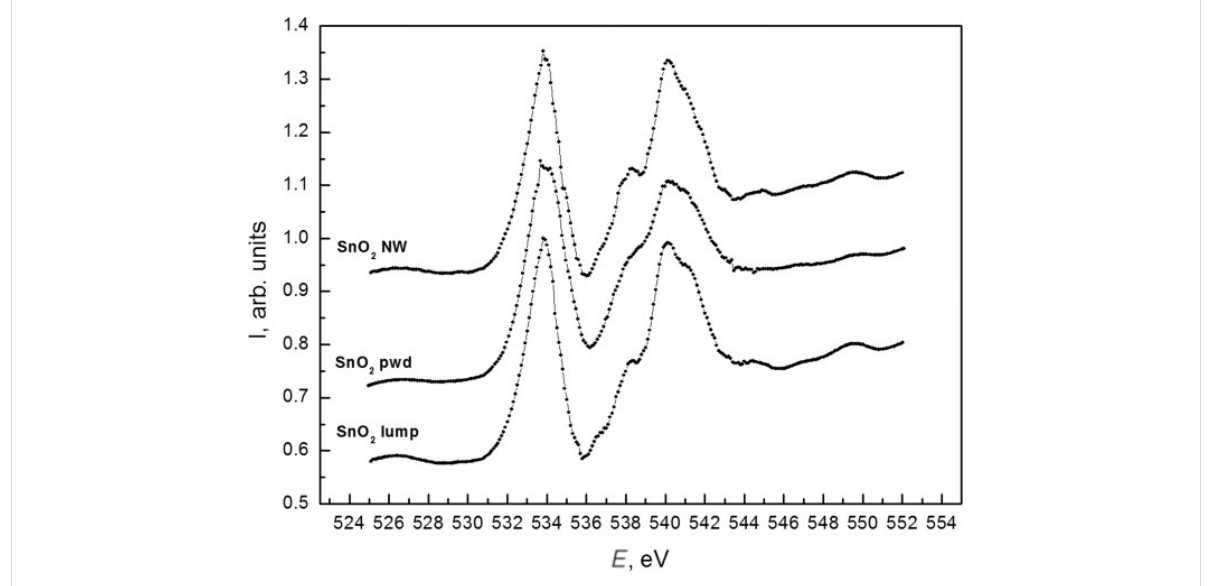
Figure 8: XANES O K spectra of SnO 2 wire-like crystals (top) [37,38], SnO 2 powder (middle) and sintered SnO 2 lump reference sample (bottom).